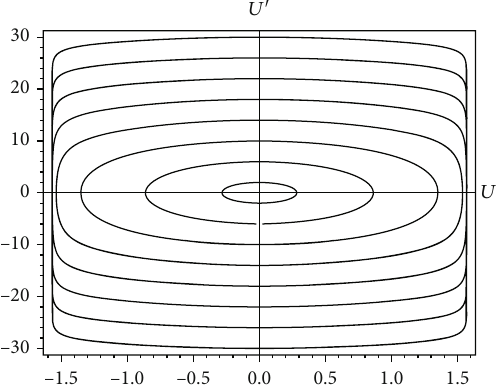
Figure 20: The central part of the phase portrait of the equation (41), where a = 50 , and b = 25 .